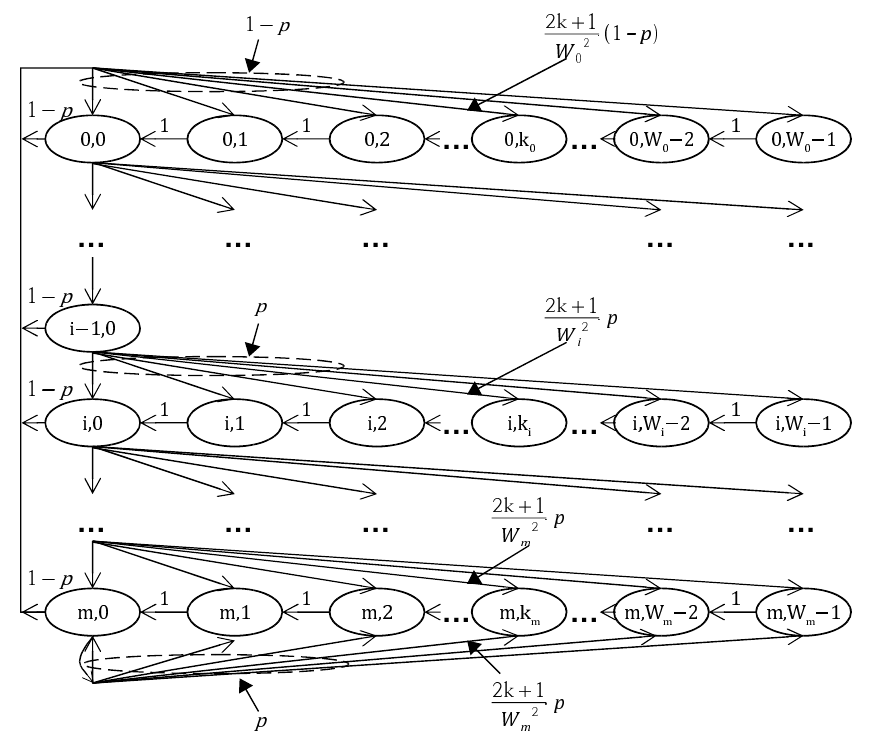
Figure 8. A simplified Markov Chain model for the backoff window size in MLA-L when the two stations are affiliated with an